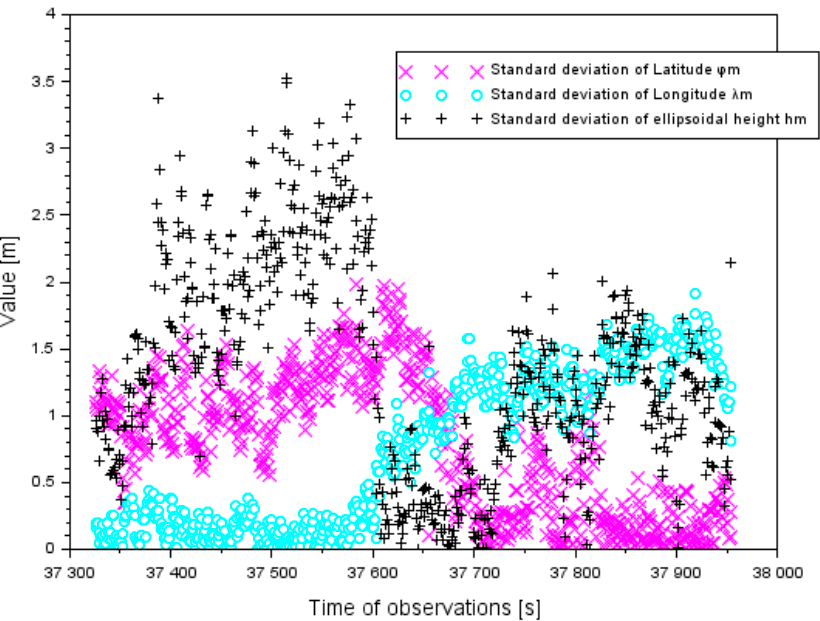
Figure 2. Standard deviation of an average aircraft position in the air test in D ę blin.